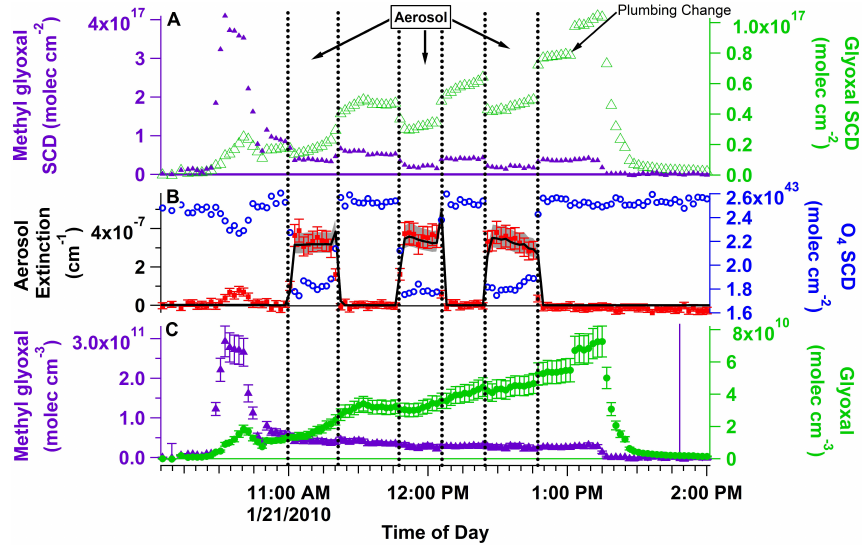
Fig. 9. Simultaneous retrieval of glyoxal, methyl glyoxal and aerosol extinction at one wavelength in closed cavity mode. (A) Slant column densities (SCD) of glyoxal (green open triangles) and methyl glyoxal (purple triangles). (B) O 4 SCD (blue circles), retrieved aerosol extinction from the change in the O 4 SCD (red squares) and the calculated aerosol extinction from Mie theory (solid line, gray area represents the uncertainty in aerosol sizing; peaks at the end of the first two aerosol periods are due to artifacts in the CPC counting). (C) Retrieved concentrations of glyoxal (green dots) and methyl glyoxal (purple triangles) corrected for path length by the retrieved aerosol